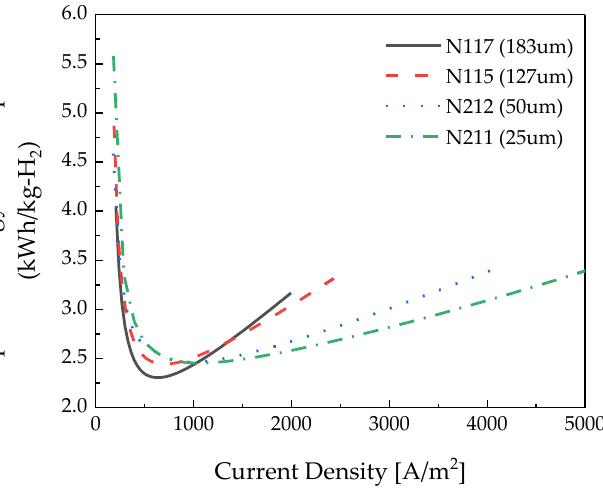
Figure 12. Specific energy consumption according to the polymer electrolyte membrane thickness.